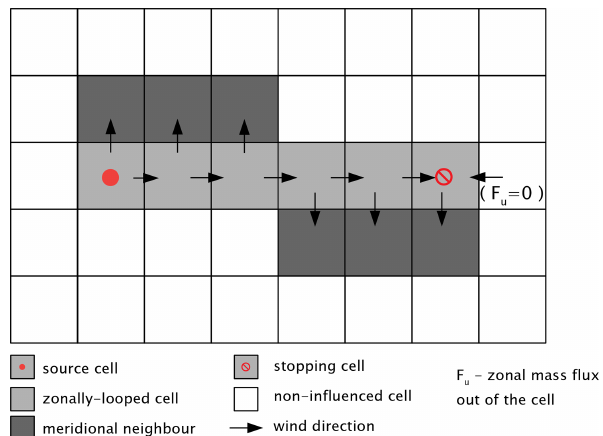
Figure 1. An illustration of advection in ChAP. Only the case when the stopping grid cell corresponds to the change of the zonal veloc- ity sign is